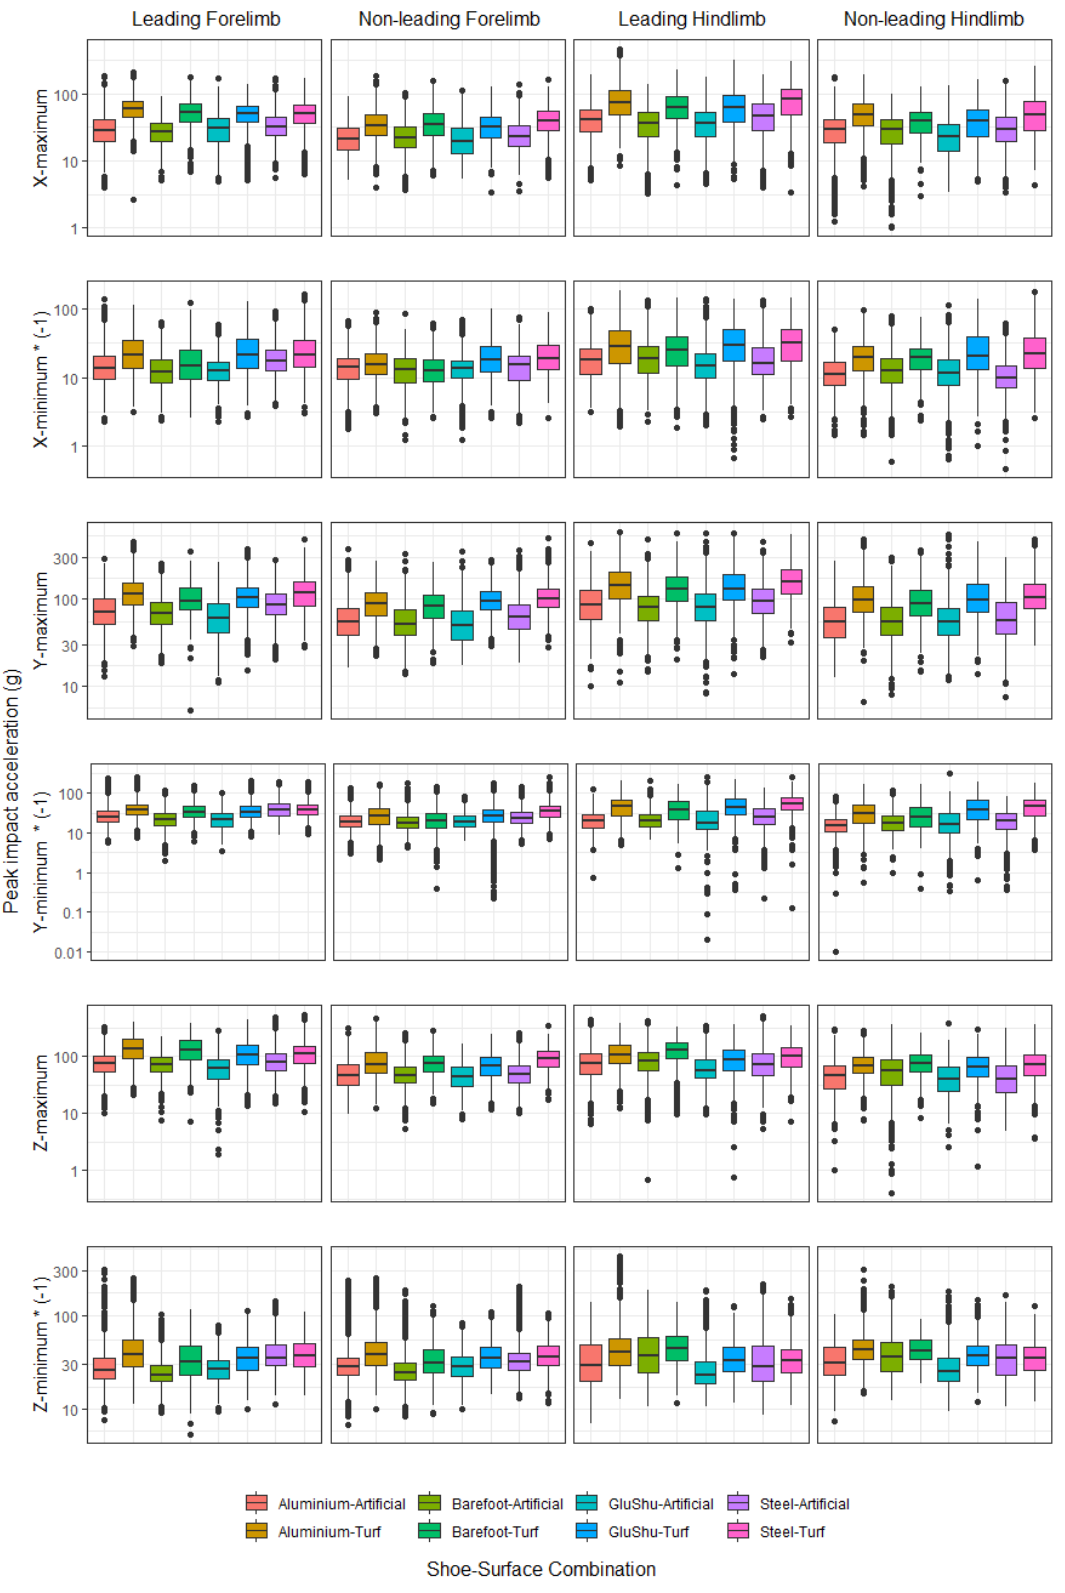
Figure A1. Boxplots illustrating minimum and maximum impact accelerations per shoe–surface combination. The p -values for pairwise comparisons (with Bonferroni correction) are provided in Supplementary Table S7. Please note that ‘*’ indicates ‘multiplied